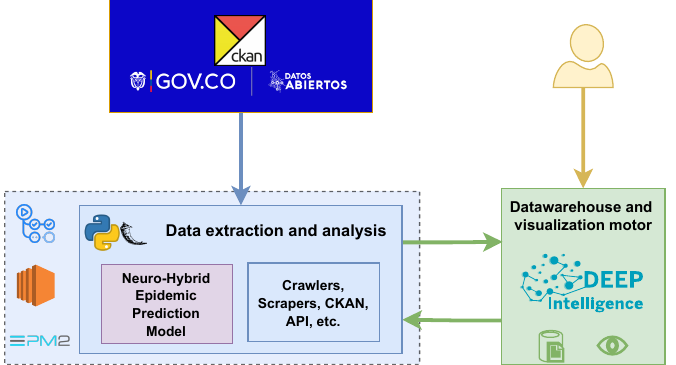
Figure 4. Architecture used to implement the proposed predictive model. The data is obtained from the CKAN server in Colombia’s open portal ( upper left ), using a Python-implemented API served with Flask ( lower left ), which also accesses additional information sources. The interaction with the Deep Intelligence platform ( lower right ) is performed by means of its API. Users ( upper right ) are able to access the platform using its graphical